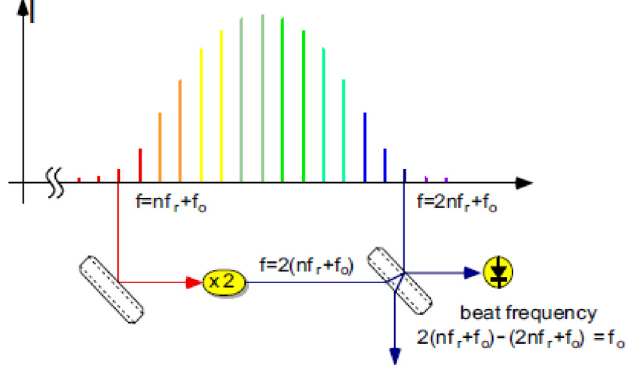
Fig. 2. The self-referencing technique of the optical frequency comb used for the measurement of the